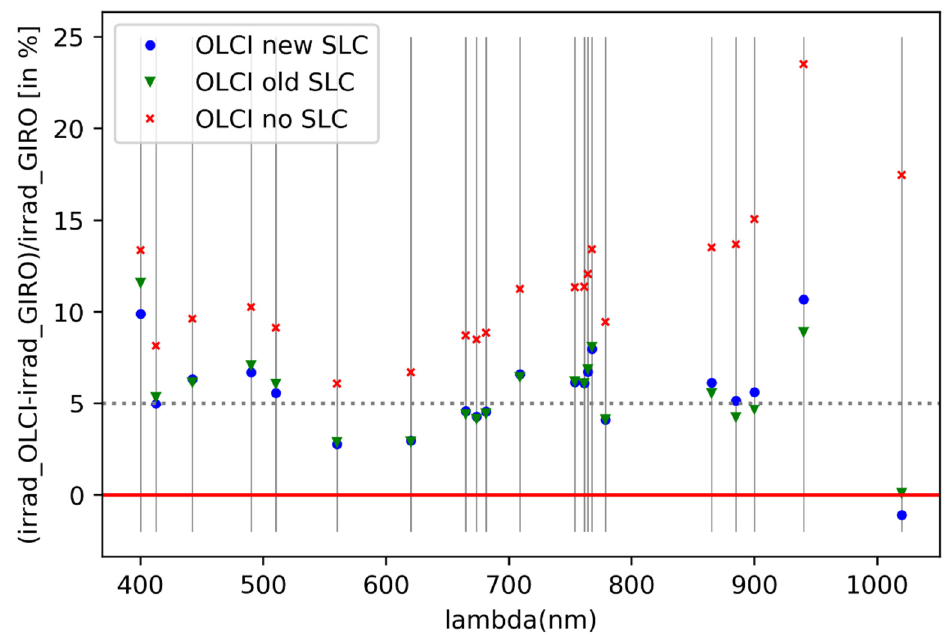
Figure 14. Comparison of OLCI calculated irradiances (with di ff erent stray-light correction (SLC)) relative to the GIRO model.